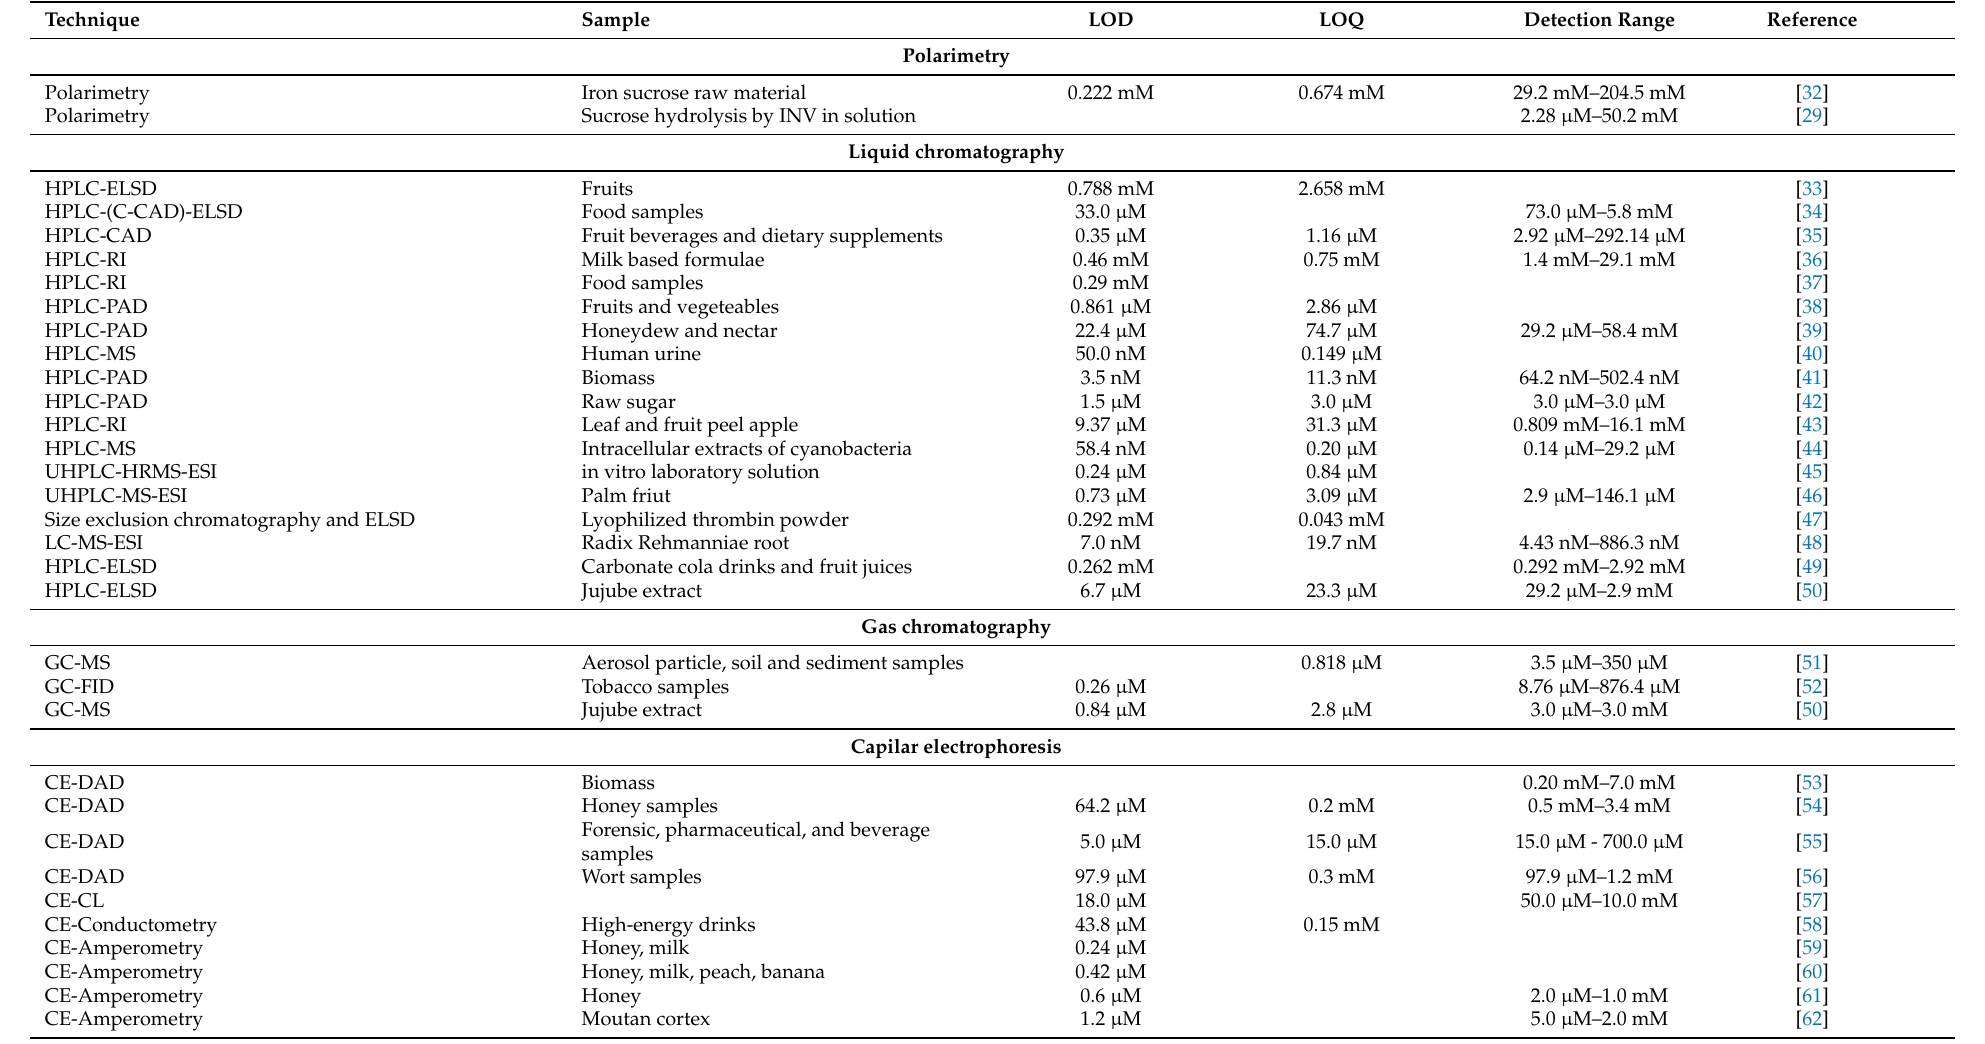
Table 2. Analytical methods for sucrose